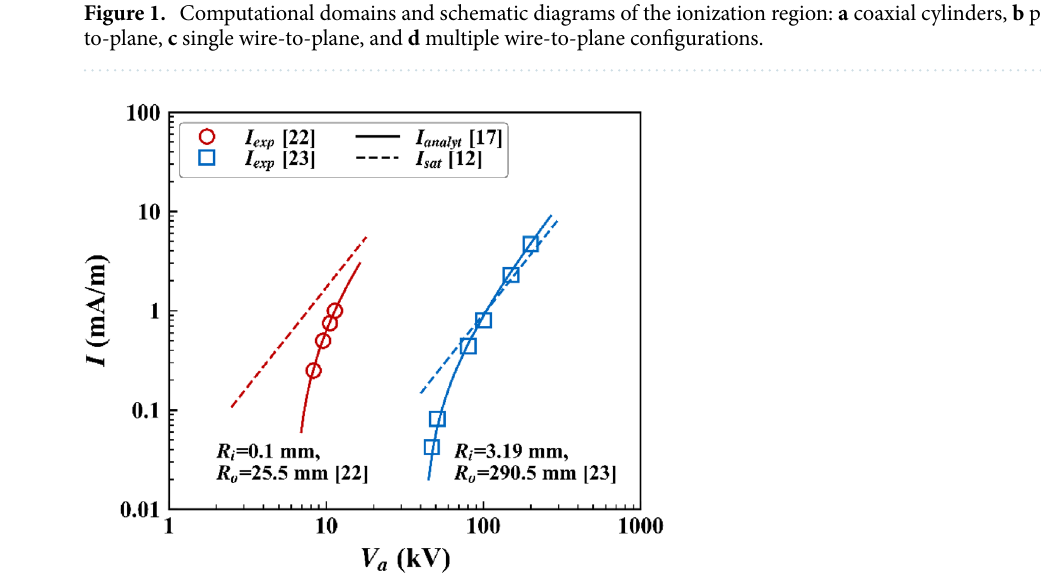
Figure 2. I exp , I analyt , and I sat of the coaxial cylinders configurations: R i = 0.1 mm and R o = 25.5 mm, and R i = 3.19 mm and R o = 290.5